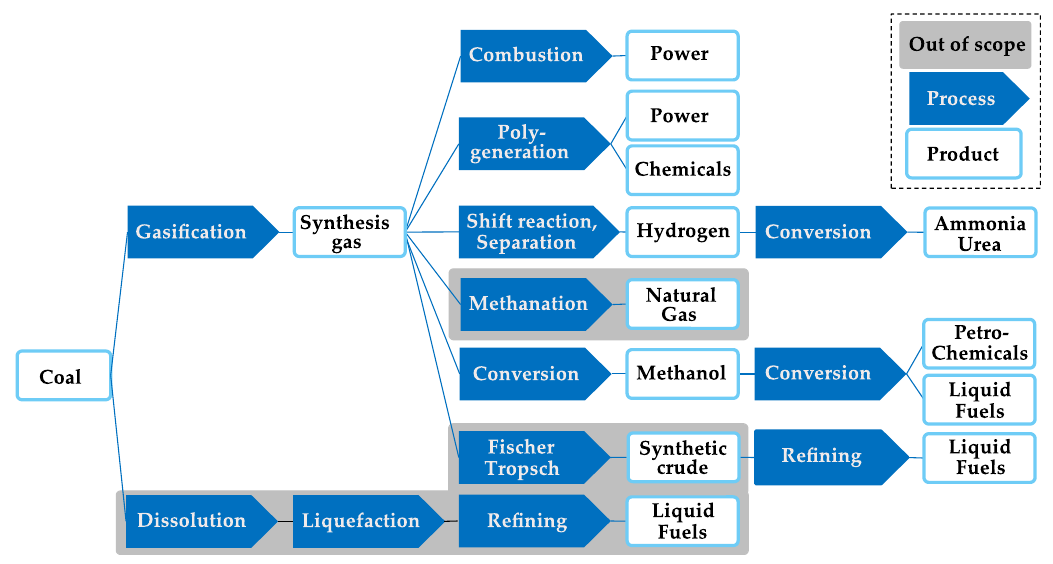
Figure 1. Supply chains for different underground coal gasification end-use options analyzed in the present study (electricity generation, hydrogen production, and its utilization for methanol and ammonia synthesis), modified from Kinaev et al. [11].